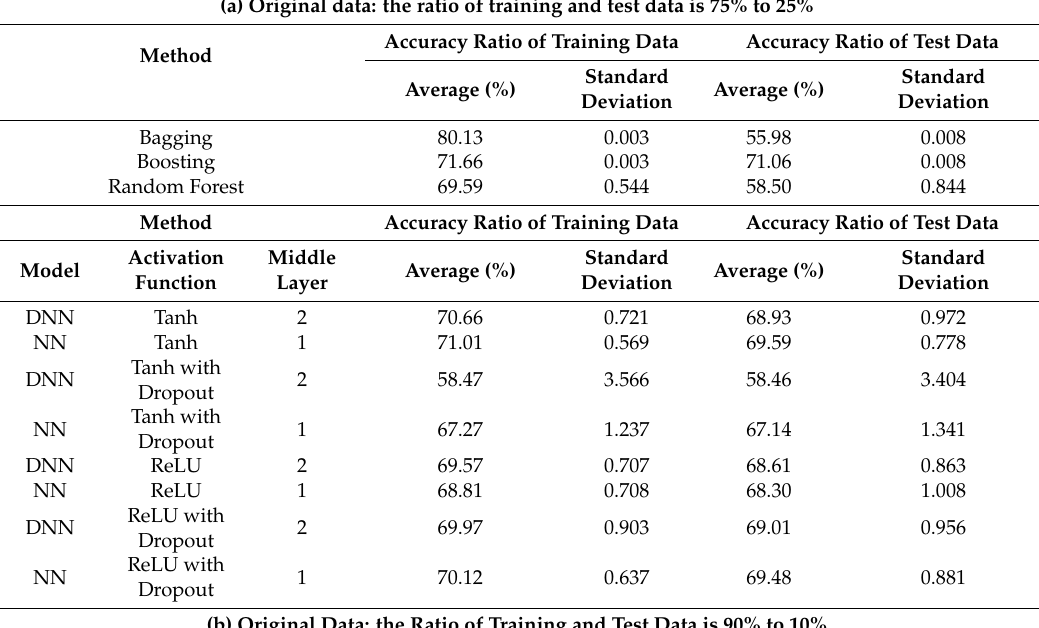
Table 2. Prediction accuracy of each method for original